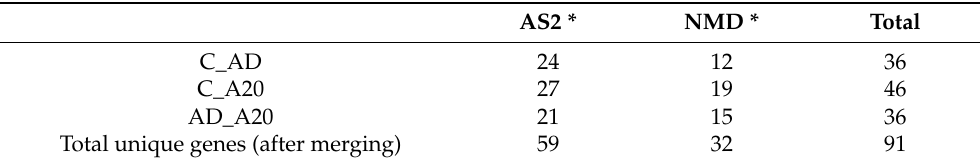
Table 2. Distribution of AS2/NMD coding ES events.